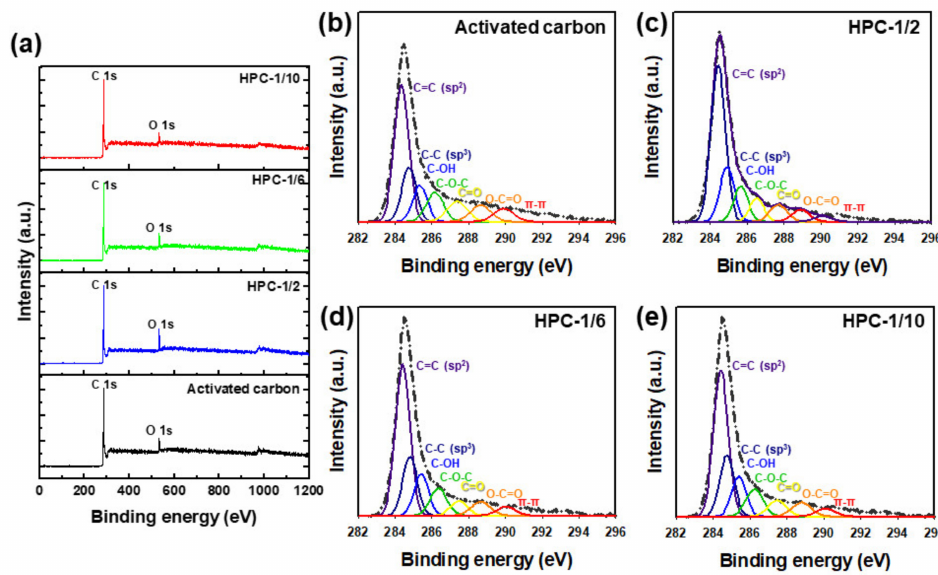
Figure 3. ( a ) XPS survey spectra and C 1s spectra of ( b ) activated carbon, ( c ) HPC-1/2, ( d ) HPC-1/6, and ( e )